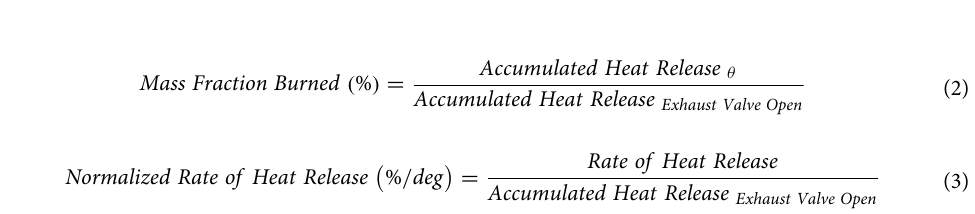
Figure 2. Experiment conditions for micro pilot (MP) injection timing, equivalence ratio, and intake air